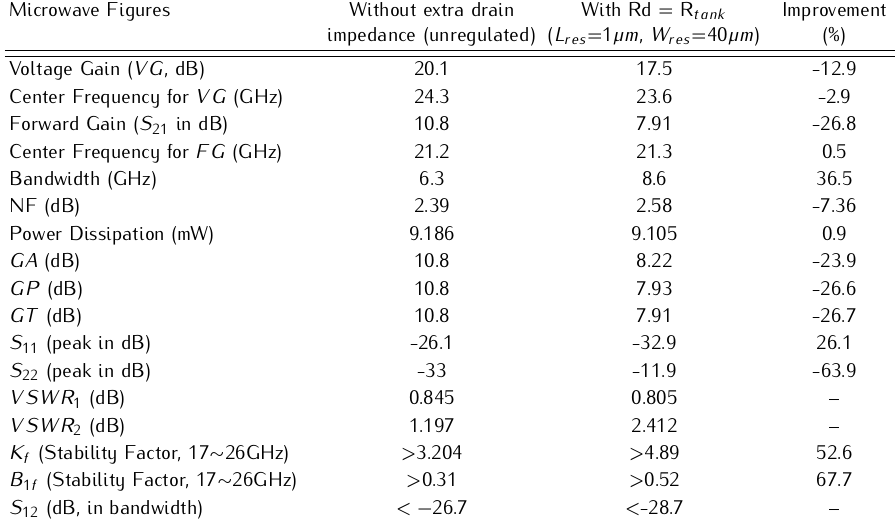
Table 2. Effect of regulation on the proposed 90nm